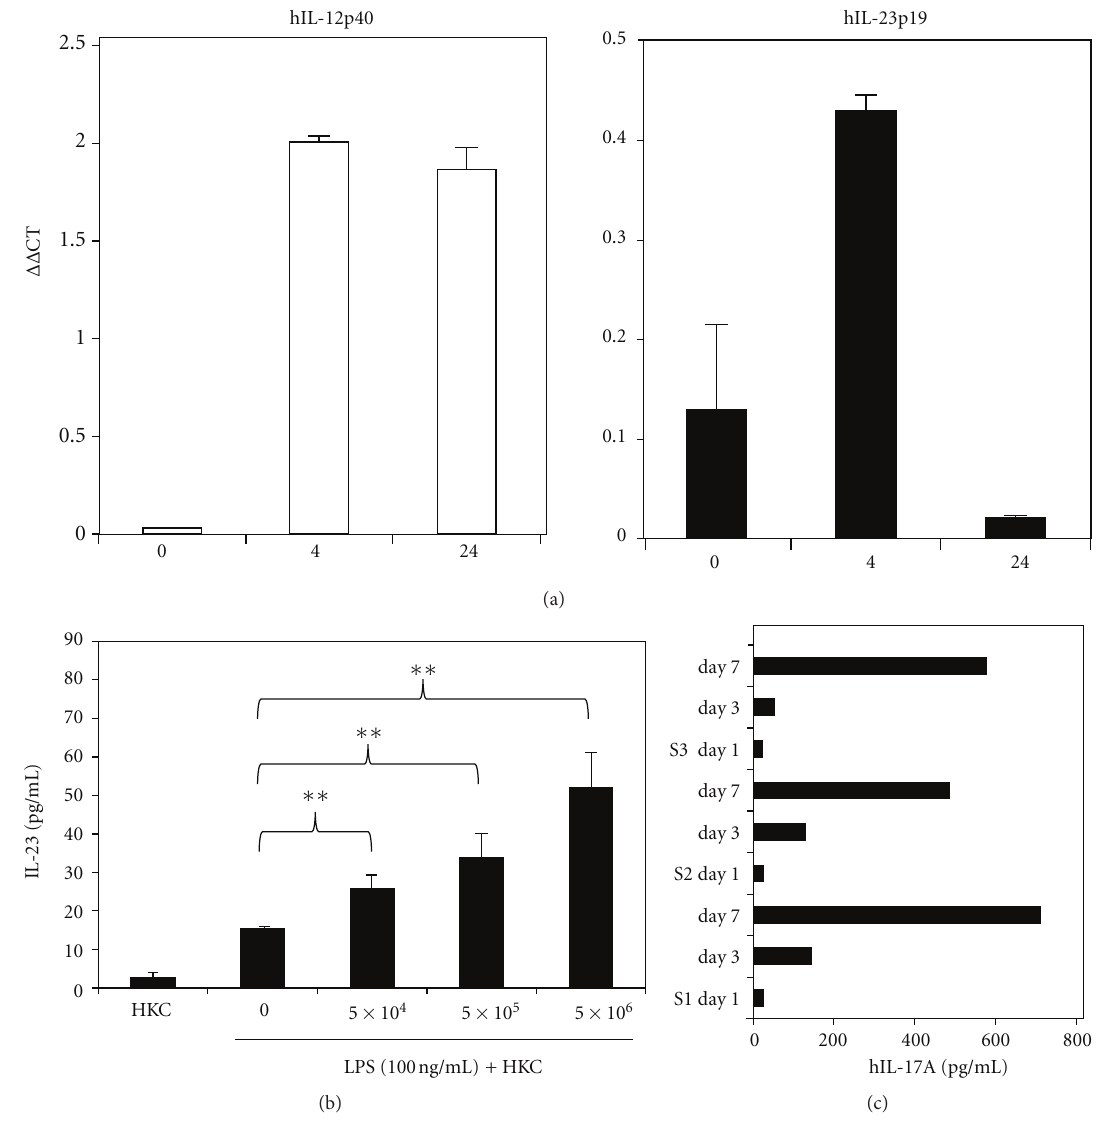
F 3: Heat-killed Candida- (HKC-) induced IL-23 expression in human monocytes in cell cultures containing LPS. (a) LPS pretreated human PBMC with HKC challenge and expression of mR�A for IL-12p4� and IL-23p19 subunits of IL-23. A signi�cantly increased IL-23 production in an LPS dose-dependent manner was evident compared to cells without LPS stimulation ( cell line (THP-1) produced IL-23 in a dose-dependent manner in the cell cultures together with LPS. (c) Human PBMC produced IL-17A aer days 1, 3, and 7 cultured with 3 different clinical strains of